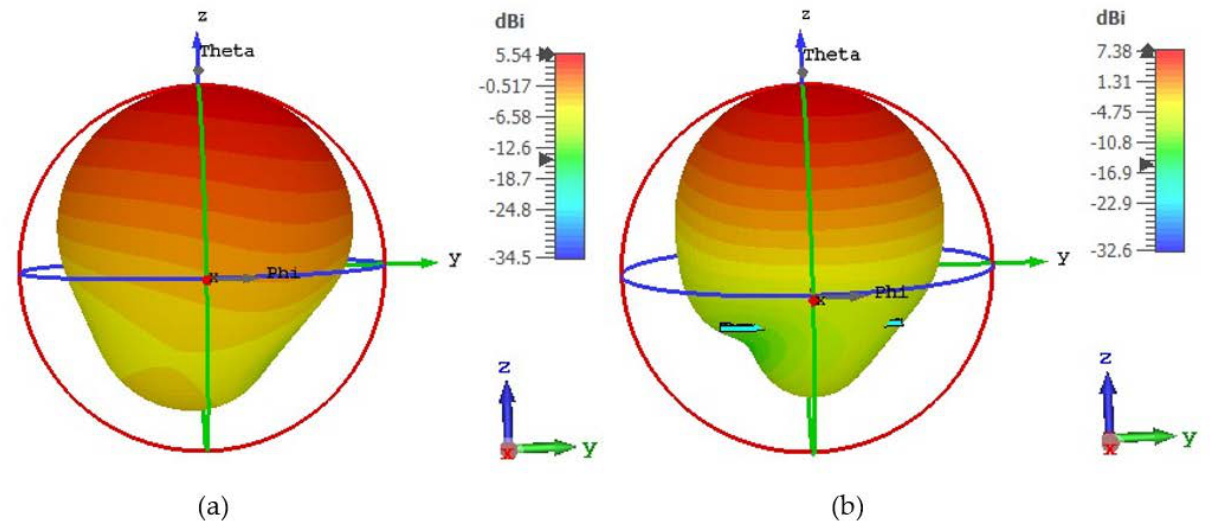
Figure 19. Three-dimensional Far-field results of the proposed antenna ( a ) without MM and ( b ) with MM reflector at 3.5 GHz.